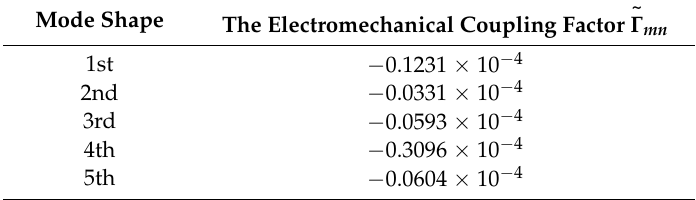
Table 2. The value of modal electromechanical coupling factor determined for the five lowest natural